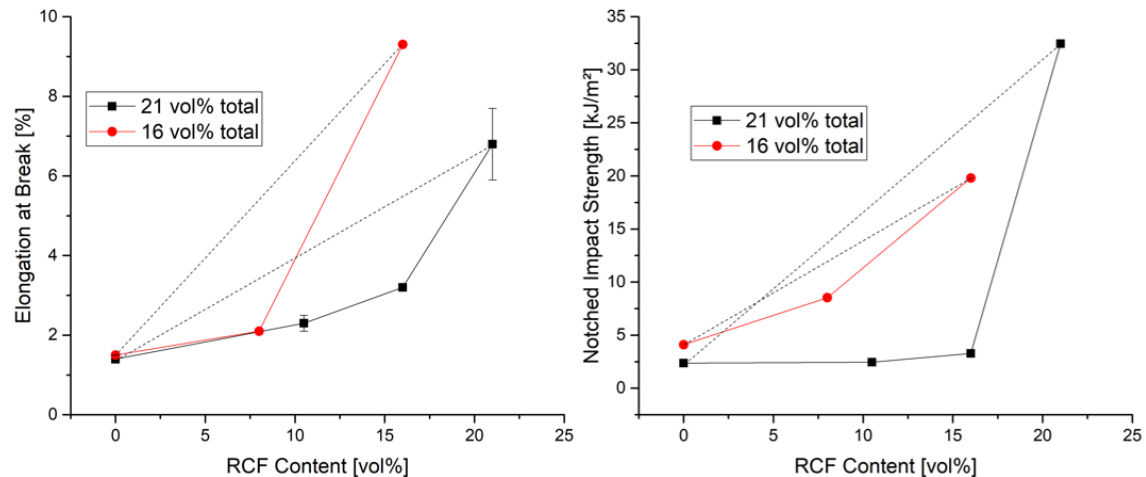
Figure 3. Elongation at Break ( left ) and Notched Impact Strength ( right ) at 16 and 21 vol% fibers with different ratios of GF/RCF and reference compounds.